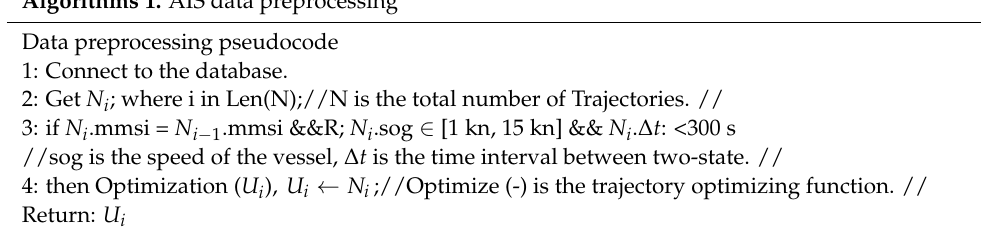
Algorithms 1. AIS data preprocessing Figure 2. MMSI = 413802216 sending time chart. Data preprocessing